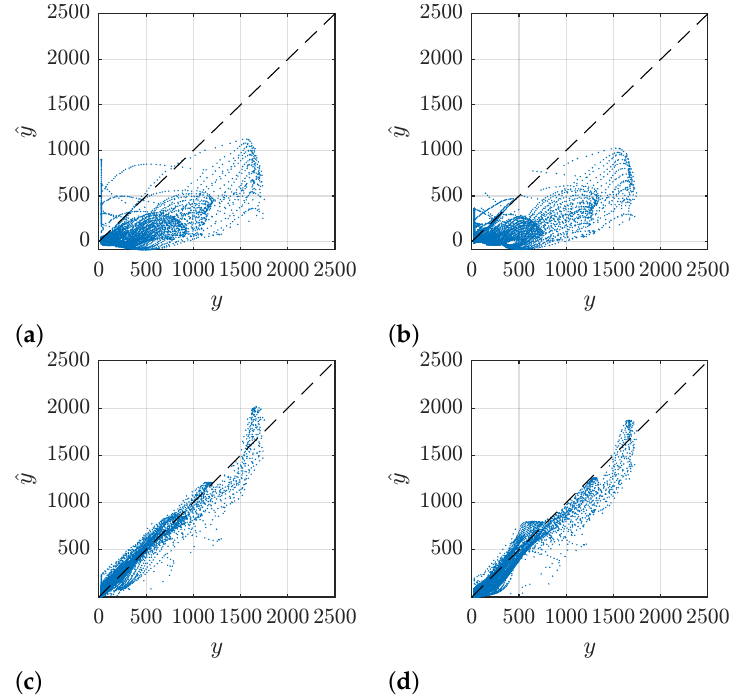
Figure 12. y versus ˆ y plots for single track case. ( a ) ARX model predictions on training data; ( b ) ARX model predictions on validation data; ( c ) OE model predictions on training data; ( d ) OE model predictions on validation data.